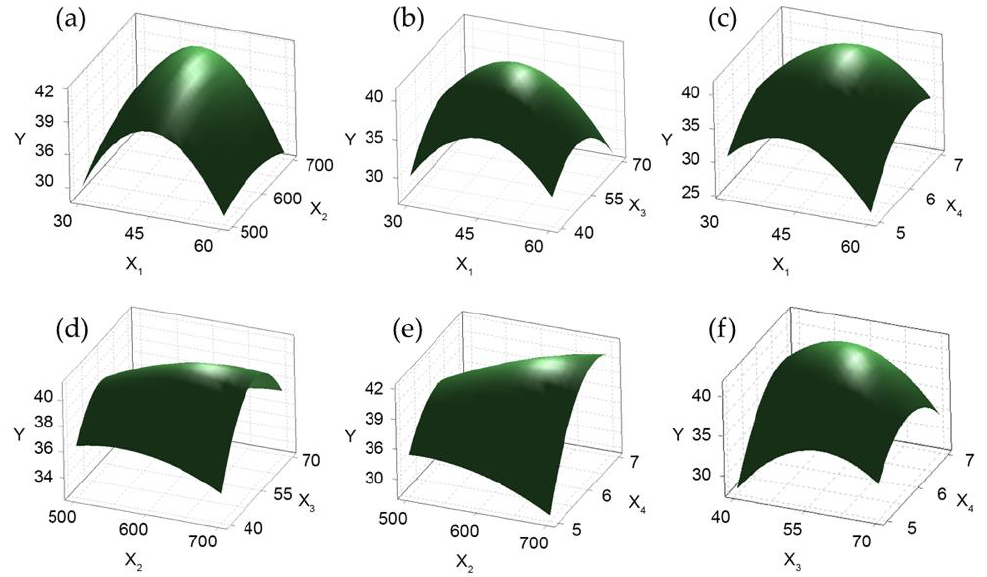
Figure 2. Response surface (3D) showing the e ff ects of variables on the yield of ulvan. E ff ects of ( a ) extraction time (X 1 ) and power (X 2 ), ( b ) extraction time and water-to-raw-material ratio (X 3 ), ( c ) extraction time and pH (X 4 ), ( d ) power and water-to-raw-material ratio, ( e ) power and pH, ( f ) water-to-raw-material ratio and pH on ulvan yield (Y, %).